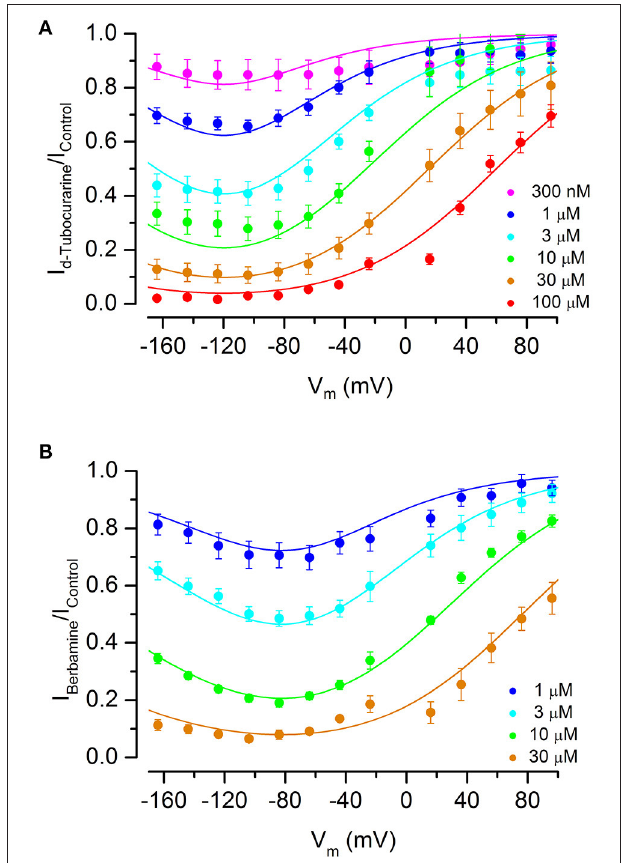
FIGURE 8 | Fractional block of the MET currents by d-tubocurarine and berbamine shows that both are permeant blockers. (A,B) Fraction of the MET current remaining during dTC (A) or berbamine (B) superfusion relative to the control current at the same membrane potential. Concentrations ranged from 300 nM to 100 µ M (dTC) or 1 to 30 µ M (berbamine). Data are fitted with a two-barrier, one binding-site model (see Section Materials and Methods). A release of the block at extreme hyperpolarized potentials indicates that both compounds can enter the cells. Maximum current block is seen at − 118 mV (dTC) and − 94 mV (berbamine). Fitted parameters were for dTC 1 E 4.96 kT; E b − 8.67 kT; z 1.09; δ b 0.52, and for berbamine 1 E 2.68 kT; E b − 12.0 kT; z 0.94; δ b 0.57. Number of cells (A) 300 nM: 5, 1 µ M: 6, 3 µ M: 9, 10 µ M: 5, 30 µ M: 13, 100 µ M: 5 (B) 1 µ M: 6, 3 µ M: 14, 10 µ M: 8, 30 µ M: 9.